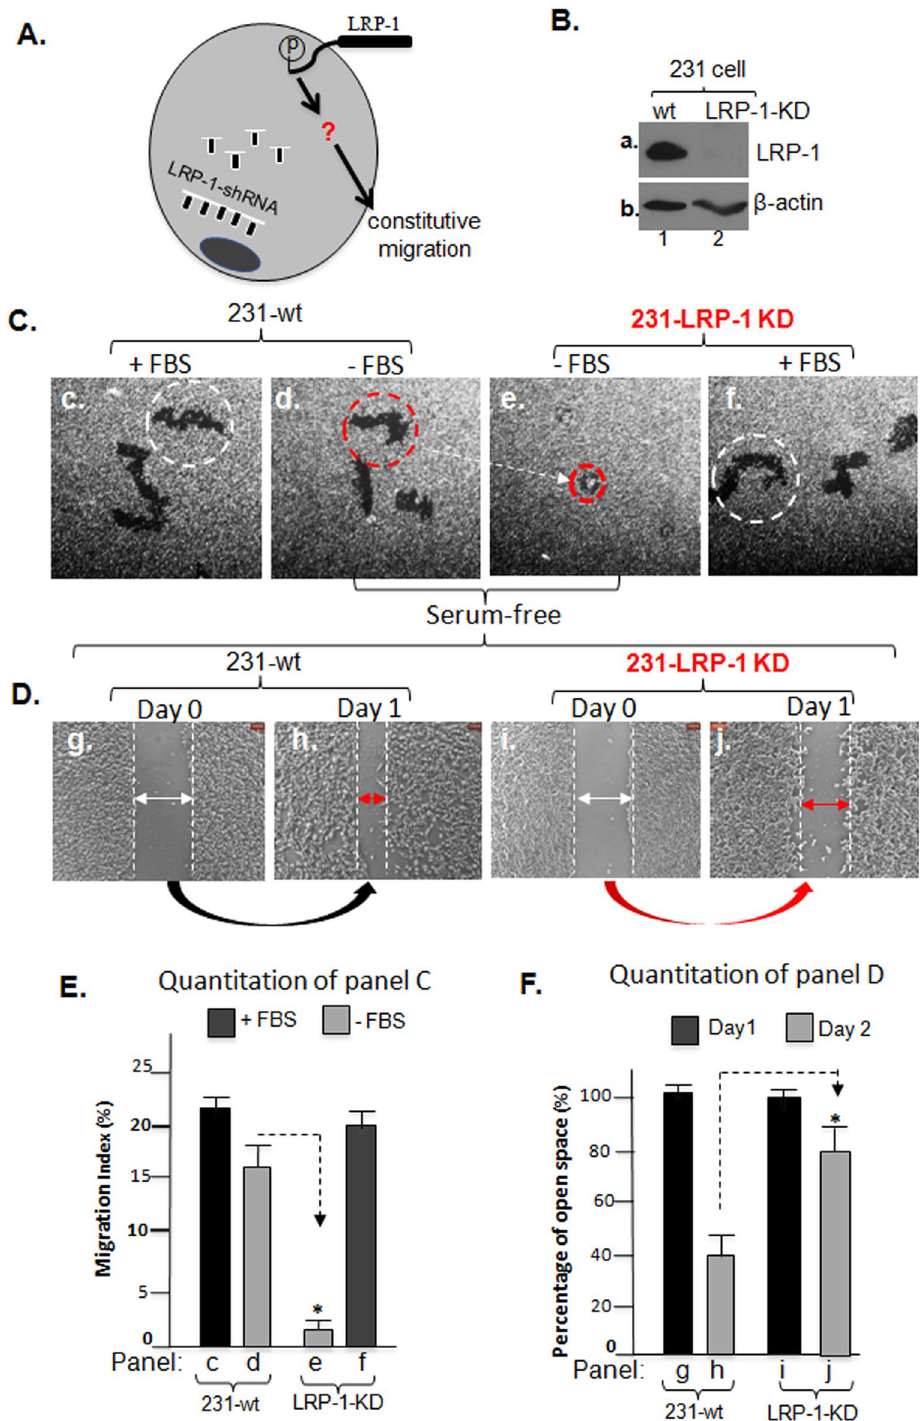
Figure 2. LRP-1 controls the full scale of constitutive motility of MDA-MB-231 tumour cells. ( A ) A schematic illustration of our hypothesis that the LRP-1 receptor controls the constitutive motility of the tumour cells. ( B ) Western blot of total cell lysates shows lentivirus-delivered shRNA down-regulation of LRP-1 in 231 cells. ( C ) Representative images of wild type and LRP-1-downregulated cell migration by colloidal gold migration assay, in which dotter circles indicate average size of migrated tracks under indicated conditions. ( D ) Representative images of wild type and LRP-1-downregulated cell migration by “scratch” assay. Dotted lines indicate the relative open and cell-free space under indicated conditions. ( E ) Computer-assisted quantitation of the cell migration shown in C as Migration Index (%) (“Methods). Asterisk indicates significant reduction in motility versus its corresponding control. ( F ) Quantitation of the average cell-free area (open space) shown in panel ( D ) as the % of the open area on day 0 (100%). Asterisk indicates significant reduction in closing the space versus its corresponding control on day 0. This experiment was repeated multiple times with reproducible